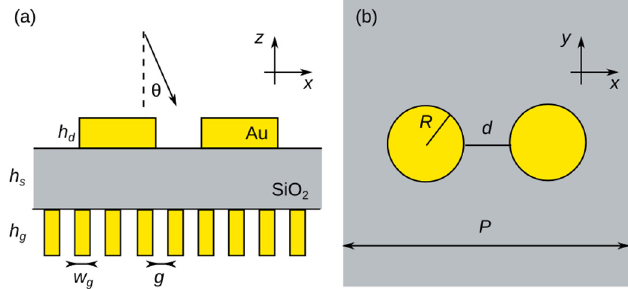
Fig. 2. Unit cell of the proposed metasurface: side (a) and top